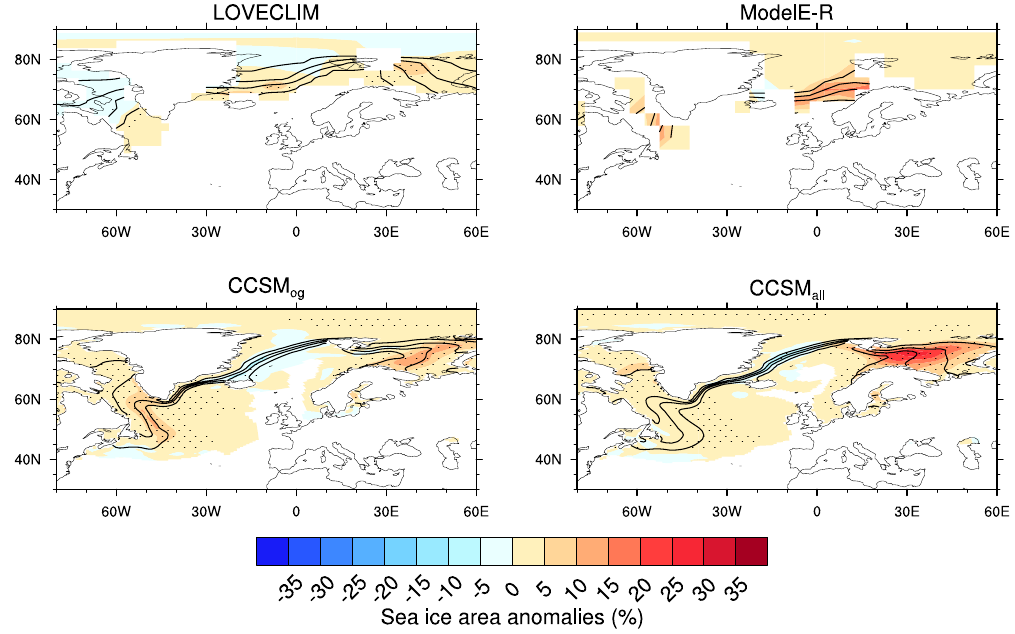
Fig. 7. Control values (contour lines) and anomalies of annual-mean sea ice area in the first fifty years following the MWP relative to the control simulation (colored contours), in percent. The contour lines show values of 5%, 25%, 50% and 75%. Stippling shows statistical significance at the 95% level according to a Student’s t test. Statistical tests were not performed for ModelE-R since only decadal averages were